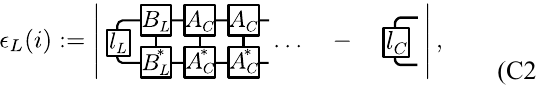
FIG. 17. Single-kink wavepacket energy as a function of the width σ for the Z 2 -symmetric Ising model g = 0.8, λ = 0, h = 0 (in the spontaneous symmetry breaking phase). We plot the energy (relative to the energy of the kink-quasiparticle momen- tum eigenstate) for two different ways of fixing the momentum- eigenstate freedom on the B tensors used to construct the wavepacket state: an orthogonal choice (cid:2) κ j | κ k (cid:3) = δ jk (left and right conditions are equivalent when h = 0) and the reflection- symmetrized choice (C17). In both cases the MPS tensors used to construct the state are tuned to the wavepacket momentum p =